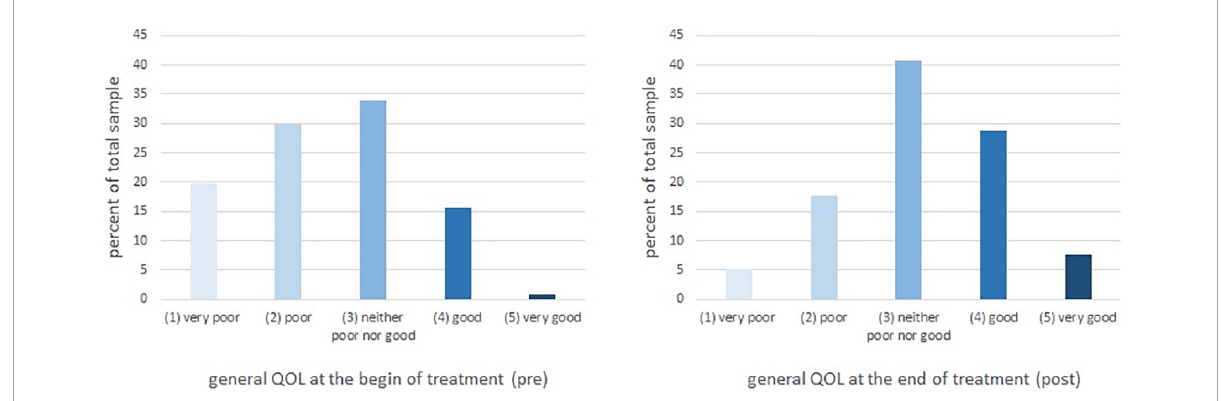
FIGURE1 Changes in general quality of life (QoL) across treatment. The proportion of patients from the total sample is displayed on the y -axis and the different intervals of general QoL between very poor (1) and very good (5) are displayed on the x